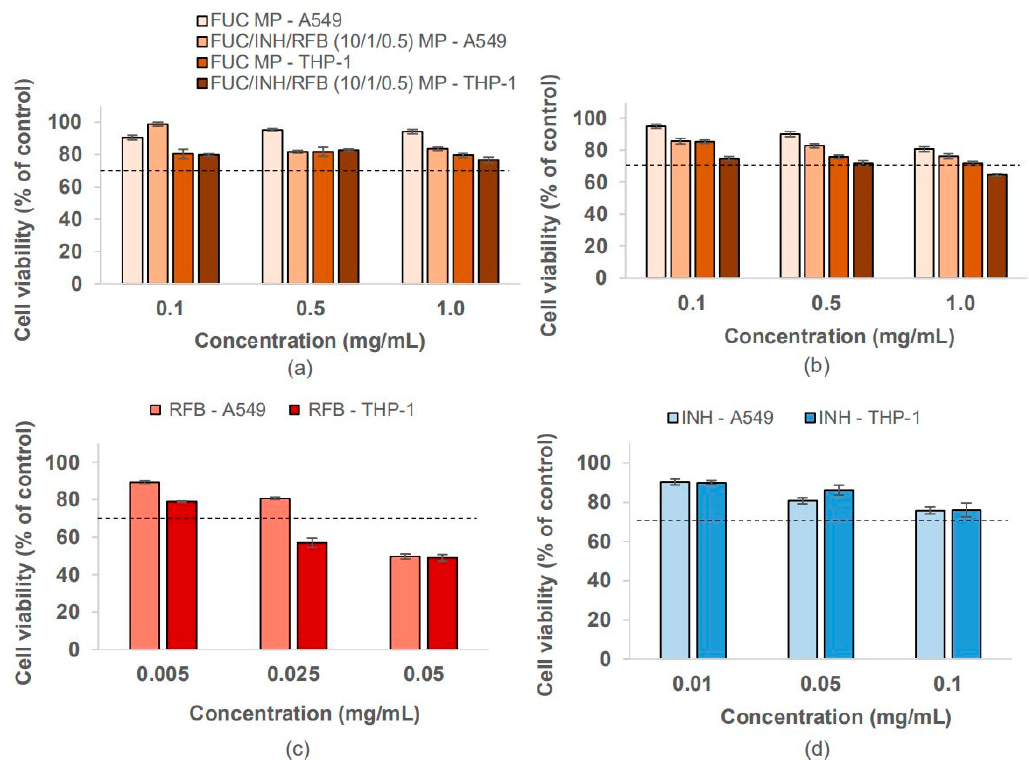
Figure 5. A549 and macrophage-differentiated THP-1 cell viability upon ( a ) 3 h and ( b ) 24 h of exposure to unloaded FUC and FUC/INH/RFB (10/1/0.5 w / w ) microparticles; ( c ) 24 h exposure to RFB as a free drug; and ( d ) 24 h exposure to INH as a free drug. Cell viability was calculated as a percentage of positive control (untreated cells). Data represent mean ± SEM ( n = 3, six replicates per experiment at each concentration). Dashed line indicates 70% cell viability. FUC: fucoidan; INH: isoniazid; MP: microparticles; RFB: rifabutin.